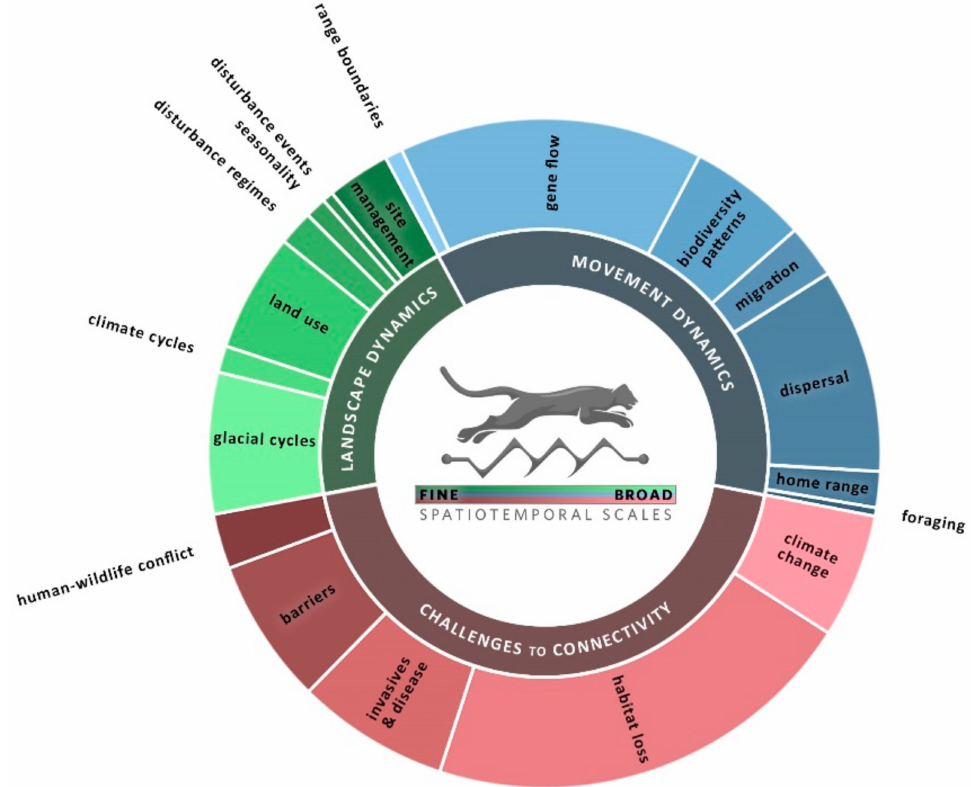
Figure 2. Distribution of 572 Circuitscape applications across the Zeller et al. [30] framing of topics in dynamic connectivity. Applications are grouped into three broad categories (inner circle), and then arranged in categories that range from finer scale (spatial or temporal) studies in darker shades, to applications at larger scales and/or longer focal time periods (lighter shades). See Table 1 for especially dynamic examples from these